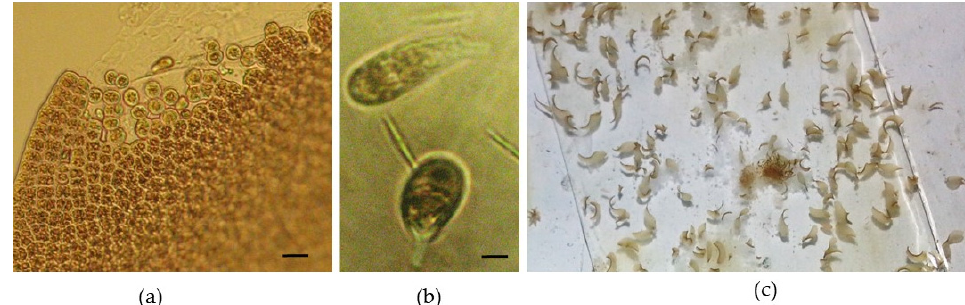
Figure 5. ( a ) Neutral-spore discharge from a newly formed young blade (scale bar: 100 μ m); ( b ) neutral spore germling (scale bar: 20 μ m); ( c ) macroscopic view of young blades . At the end of the experiment, the maximum dimensions were 80–90 mm (Figure 6a–